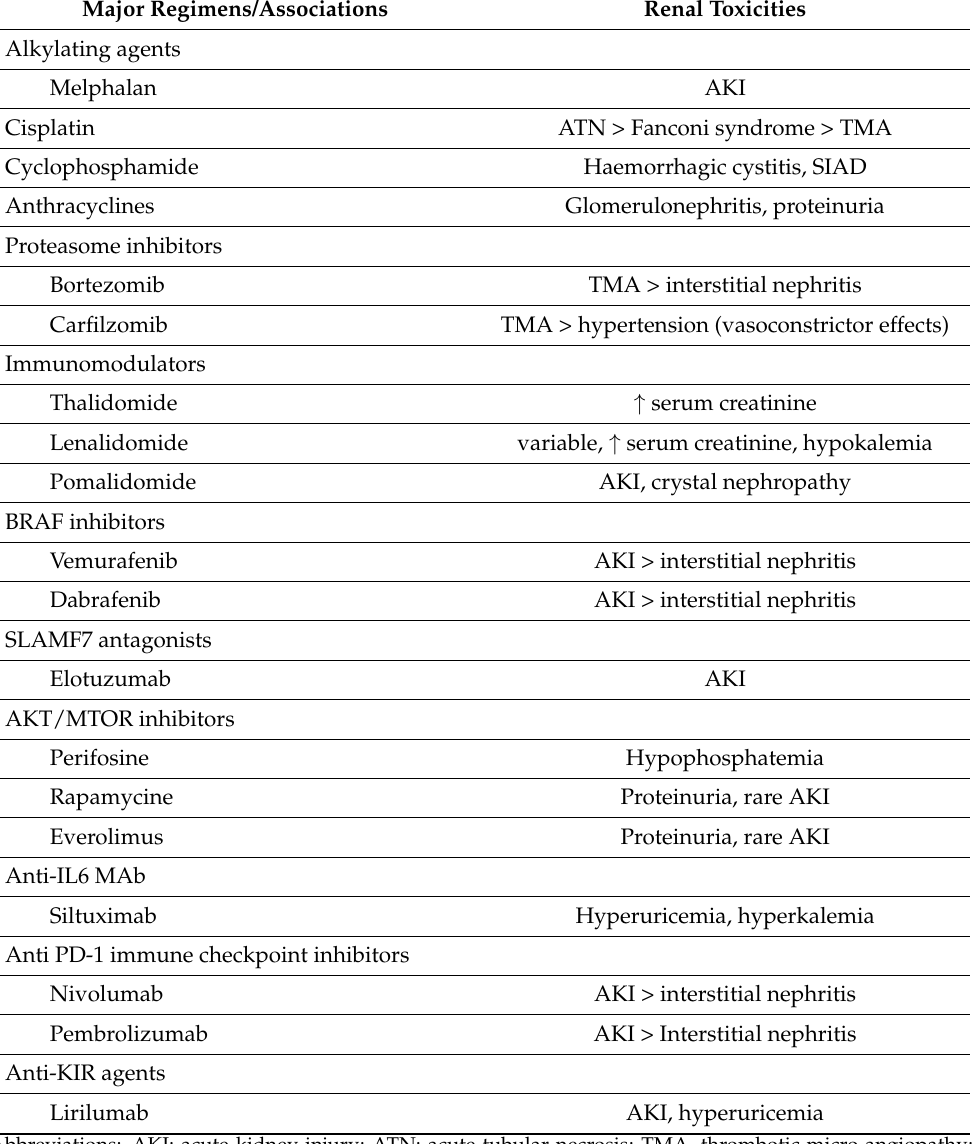
Table 3. Adverse reactions/toxicity of agents currently employed for treatment of